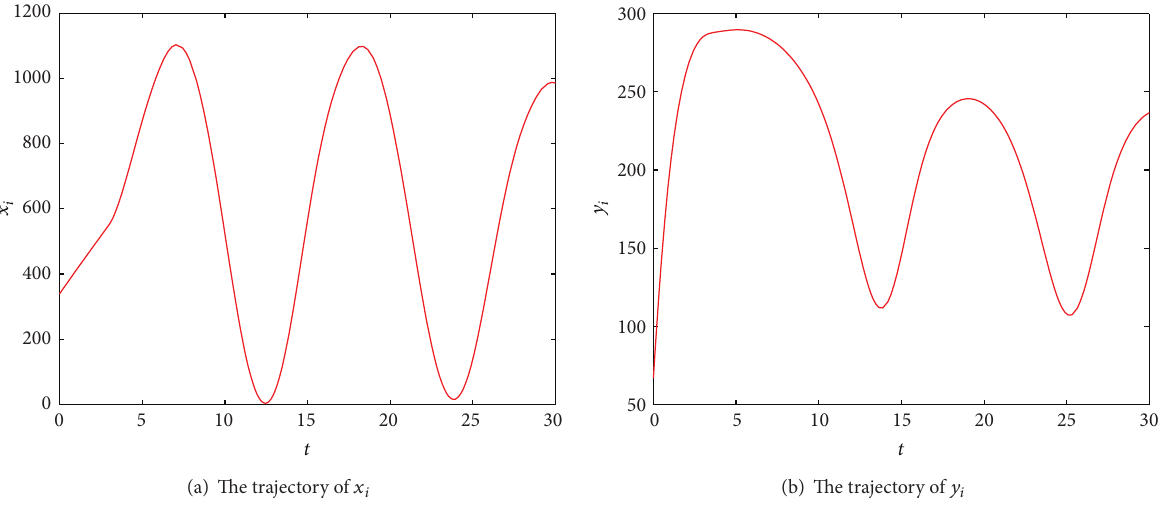
Figure 2: The trajectories of 𝑥 𝑖 and 𝑦 𝑖 occur oscillations when 𝜏 0 = 3 .